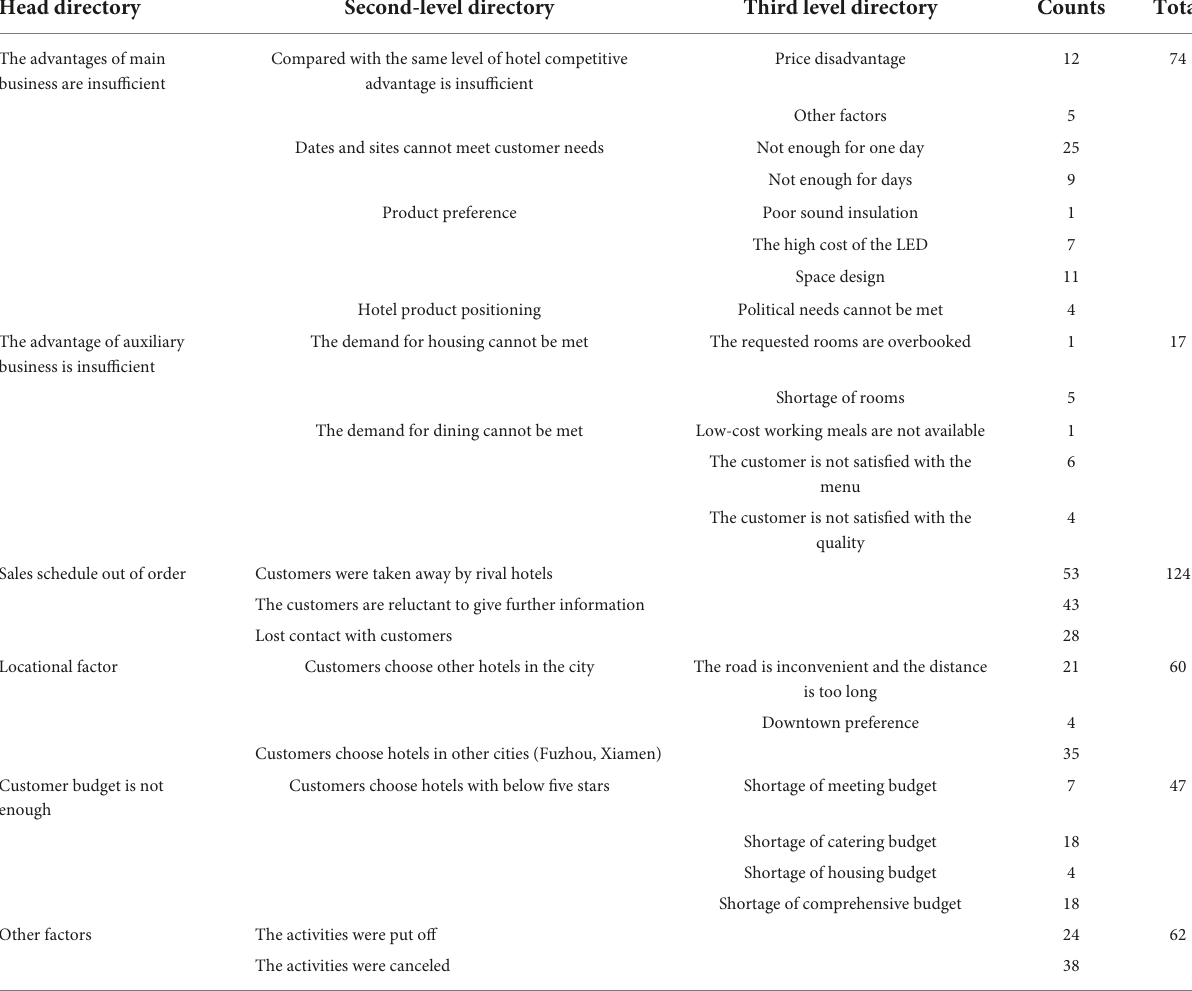
TABLE 3 Reasons for marketing